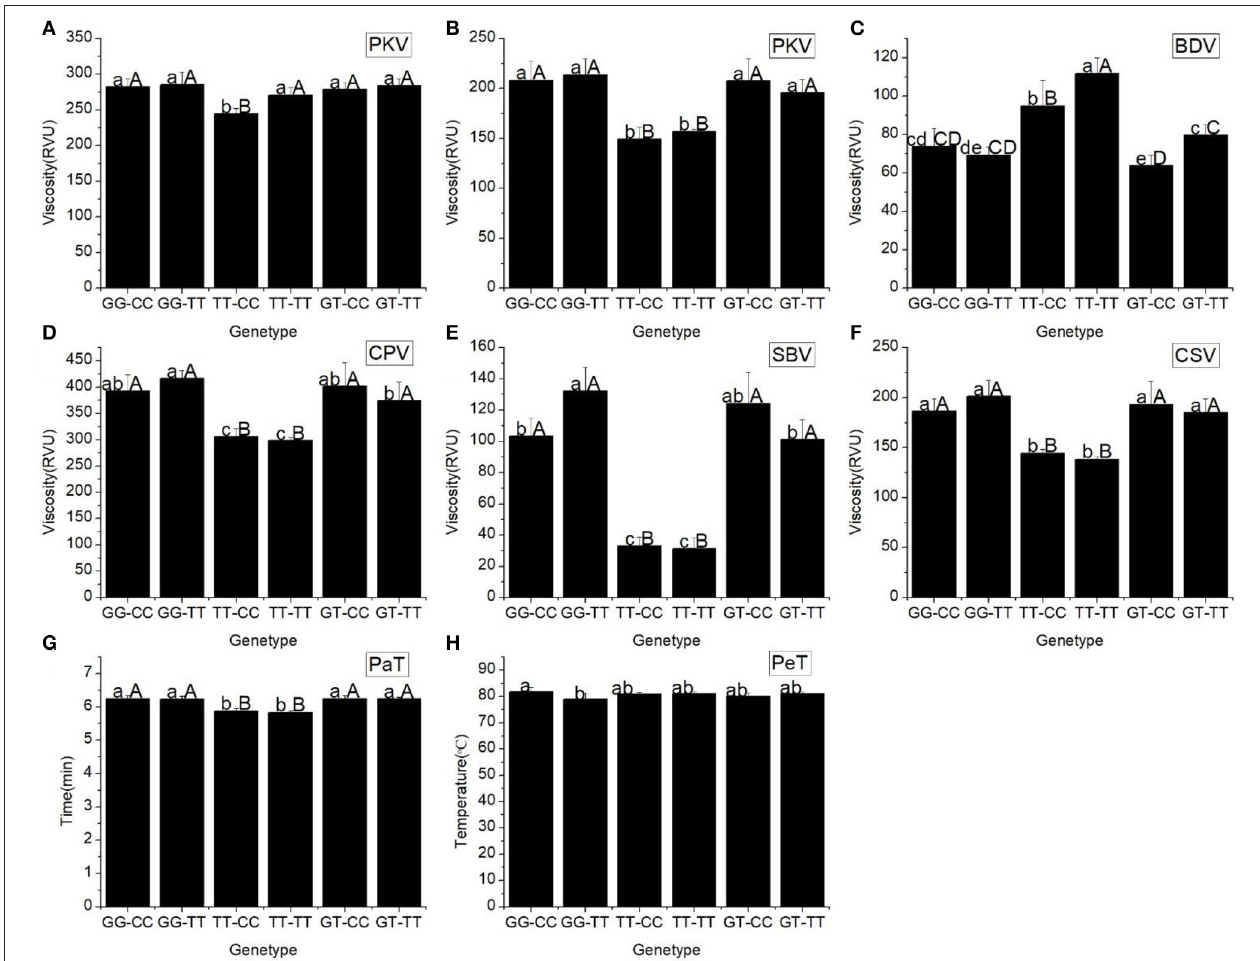
FIGURE 2 | RVA profile characteristics for different haplotypes of In1G/T and Ex10C/T polymorphisms of Wx . (A) Peak viscosity (PKV). (B) Hot paste viscosity (HPV). (C) Cool paste viscosity (CPV). (D) Breakdown valve (BDV). (E) Setback valve (SBV). (F) Consistency valve (CSV). (G) Pasting temperature (PaT). (H) Pasting time (PeT). GG-CC, GG-TT, TT-CC, TT-CC, GT-CC and GT-TT represent different haplotypes of In1G/T and Ex10C/T polymorphisms of Wx . Lowercase and capital letters above column denote significant at 0.05 and 0.01 levels,